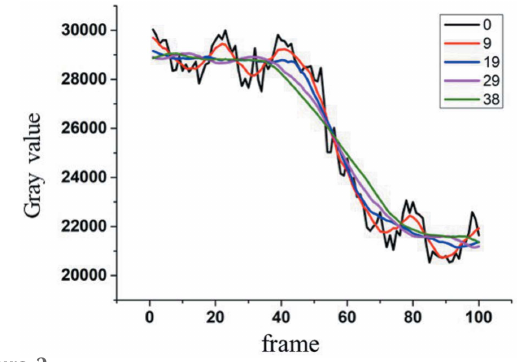
Figure 2 Time-sequenced signals at a vein processed with different window